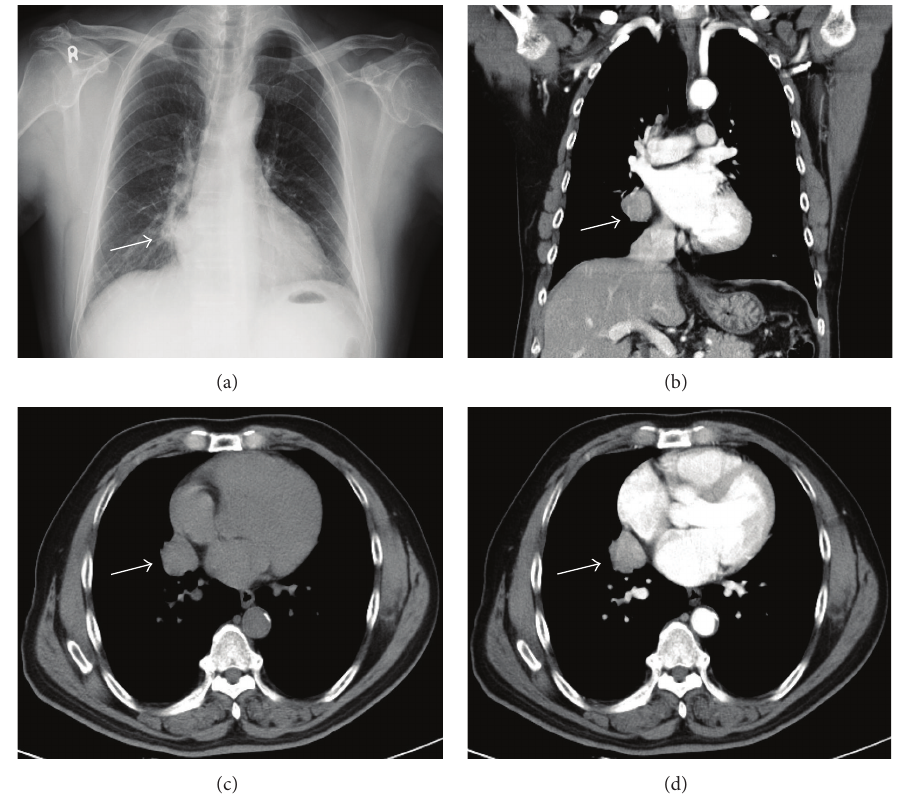
Figure 1: (a) Chest X-ray showed a mass lesion in the right paramediastinal region (arrow); (c) Noncontrast-enhanced CT scan: an isodensity lobulated mass lesion in the right middle lobe of lung; ((b) and (d)) Chest CT scan showed a 30 × 29 mm heterogenously enhanced mass lesion with well-defined lobulated margin in the right middle lobe of lung, abutting the mediastinum.